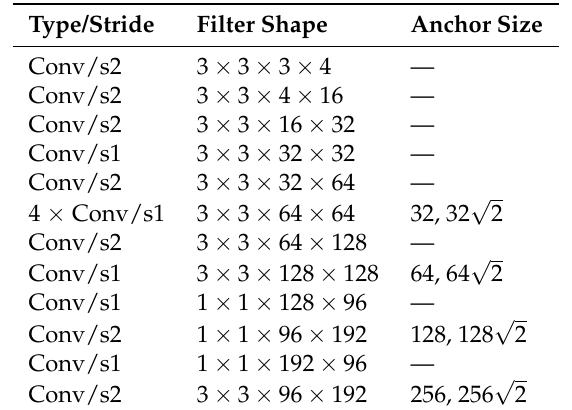
Table 1. Architecture of the backbone of the baseline face